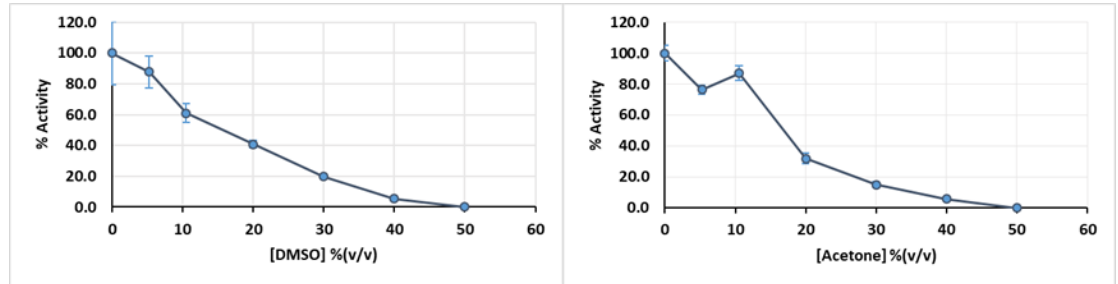
Figure 5. Effect of DMSO (left panel) or acetone (right panel) in enzymatic extract activity at pH 4.5. Error bars represent standard deviation.